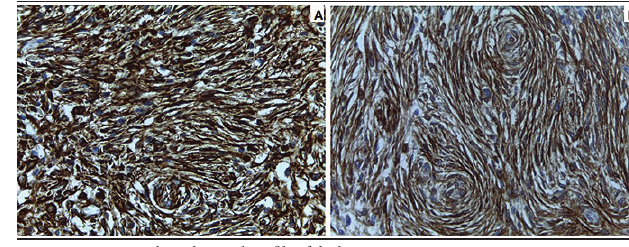
Figure 2 – Immunohistochemical profile of the lesion A) vimentin-positive; B)